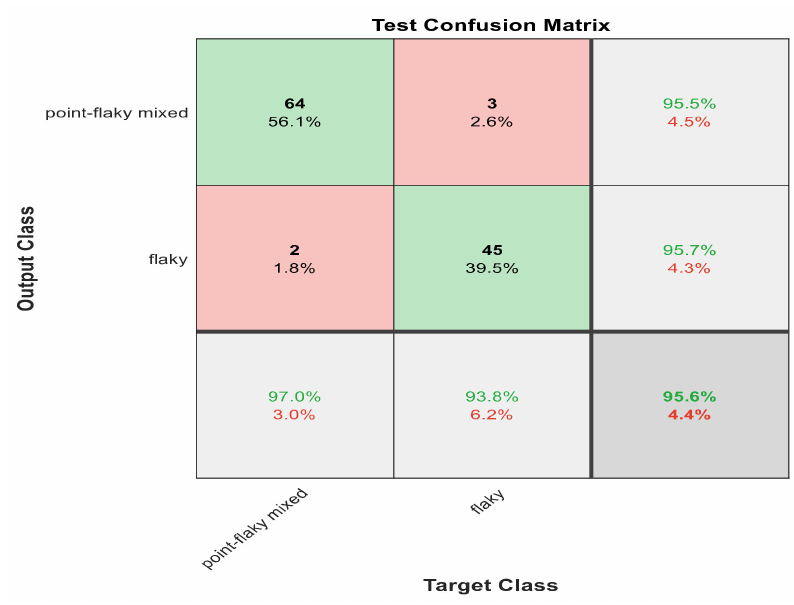
Figure 9. The confusion matrix with ECFS-reduced features for Model